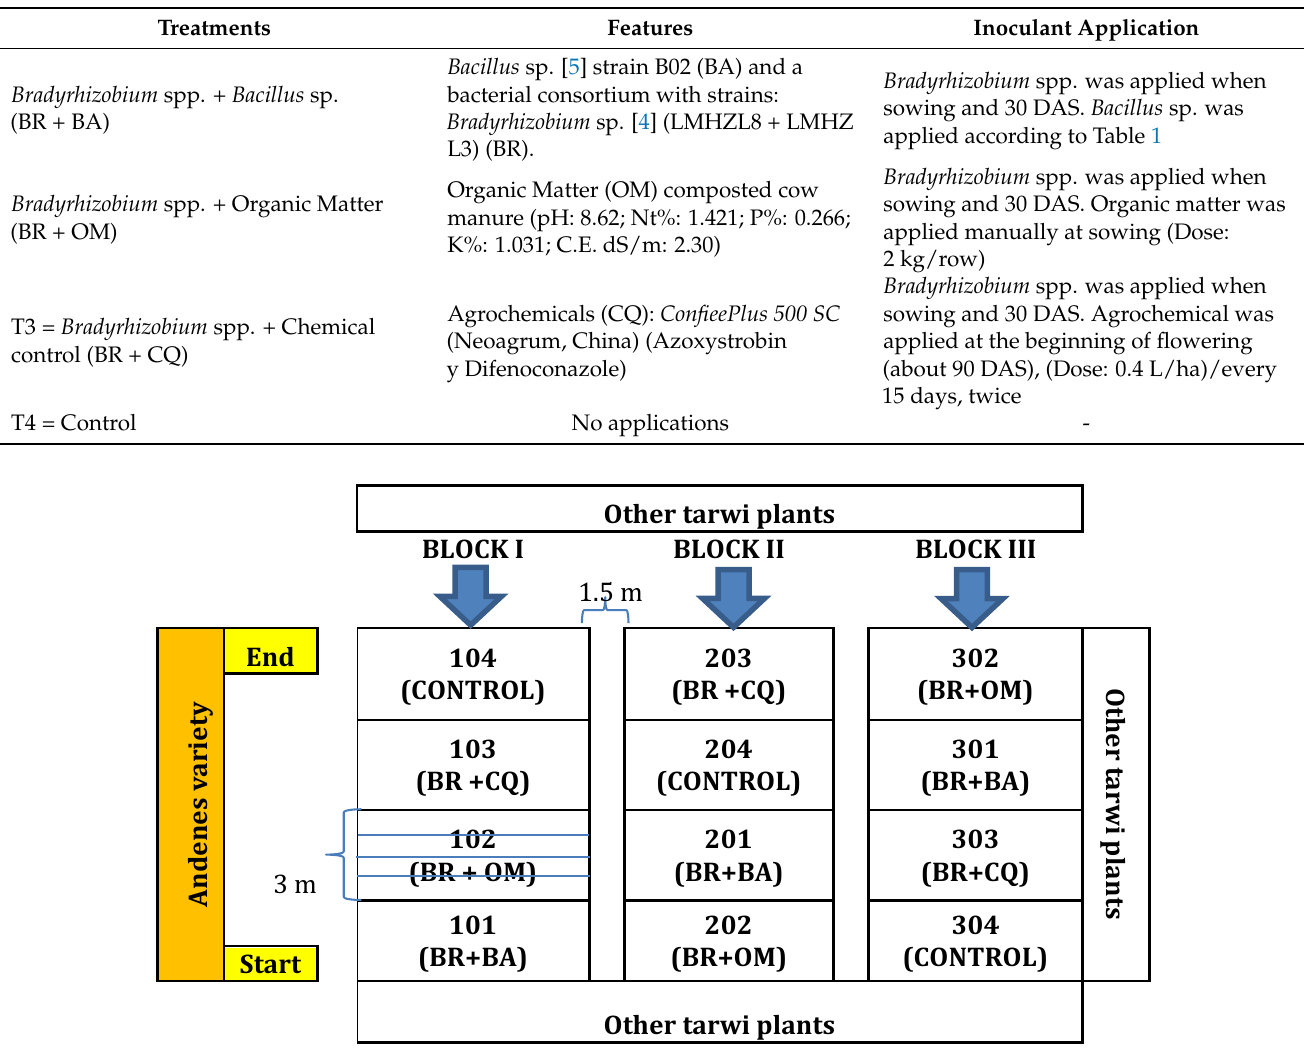
Figure 1. Distribution of treatments in the field. The 3 blue horizontal lines are the 3 rows.